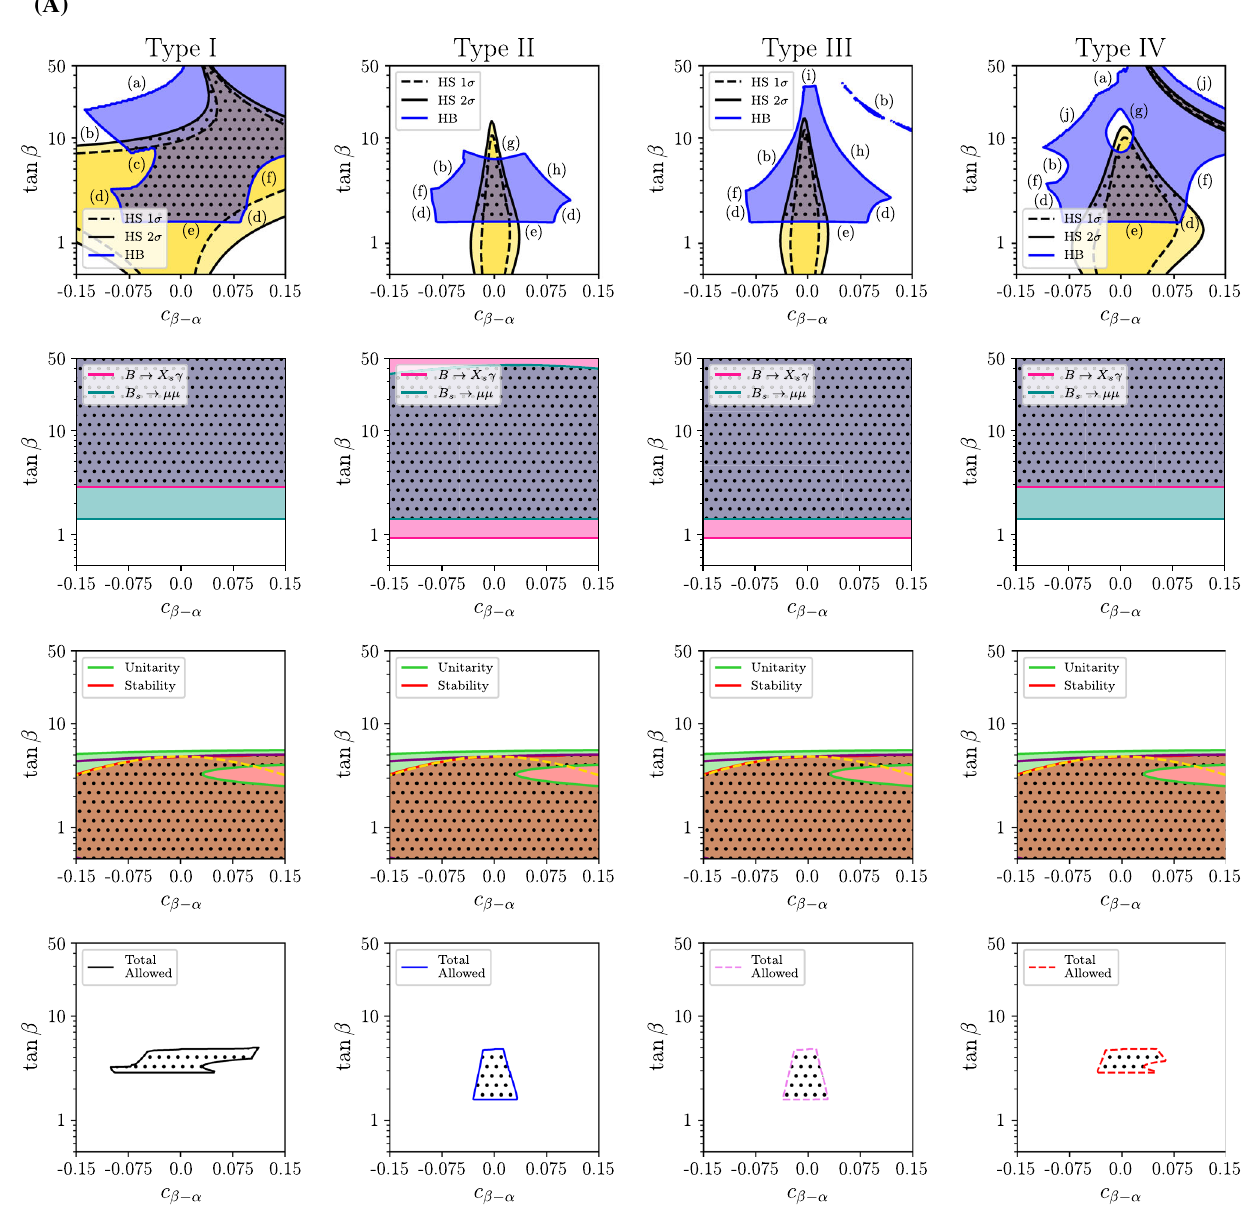
Fig. 1 A Allowed regions from the restrictions on the parameter space in benchmark scenario 1 in the c β − α –tan β plane with m = 550 GeV = 60 , 000 GeV 2 .TheresultsfortypeI,II,IIIandIVintheleft, and m 2 12 second,thirdandrightcolumn,respectively.Theupper,secondandthird row show the restrictions from HiggsBounds / HiggsSignals , the flavor observables and from unitarity/stability, respectively. The fourth rowindicatestheregionsallowedbyallconstraintsintherespectivesce-